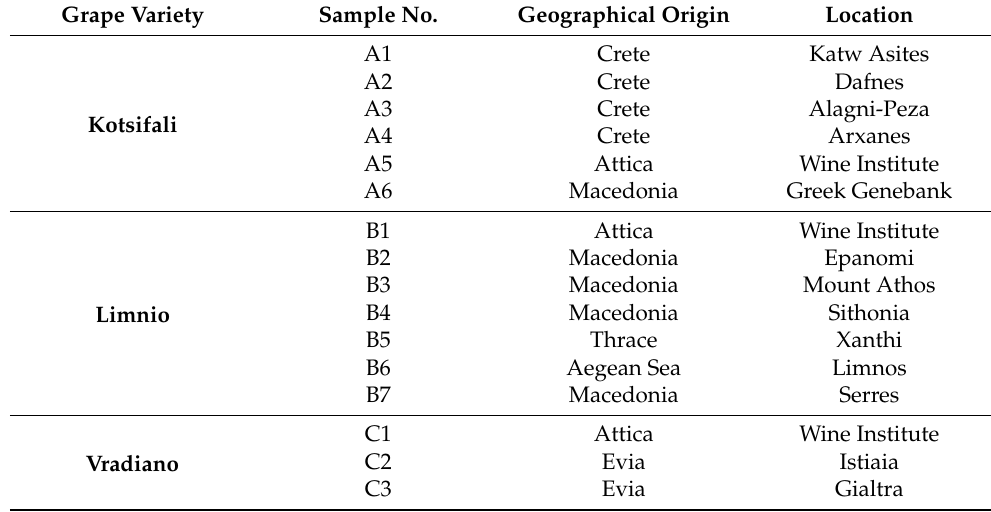
Table 8. Variety and geographical origin of the samples. Grape Variety Sample No. Geographical Origin